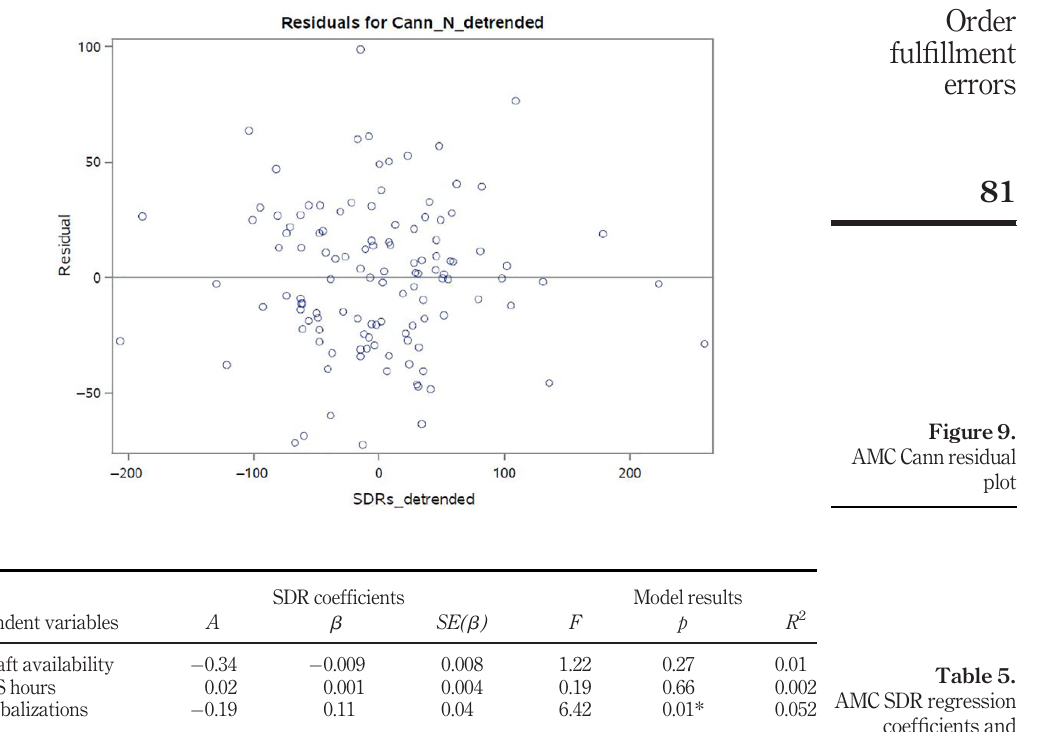
Table 5. AMC SDR